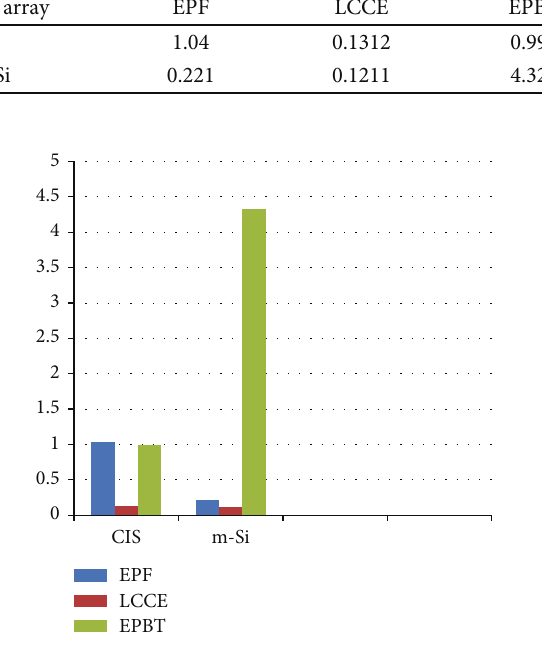
Figure 11: PV equipment ’ s energy